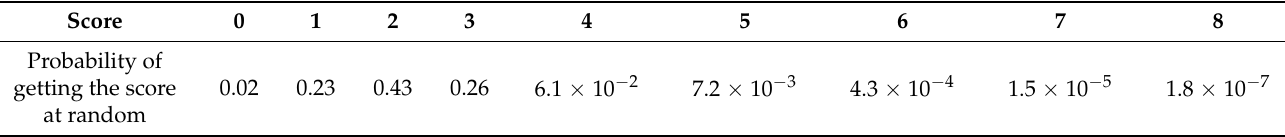
Table 3. Probability of a given score with a random